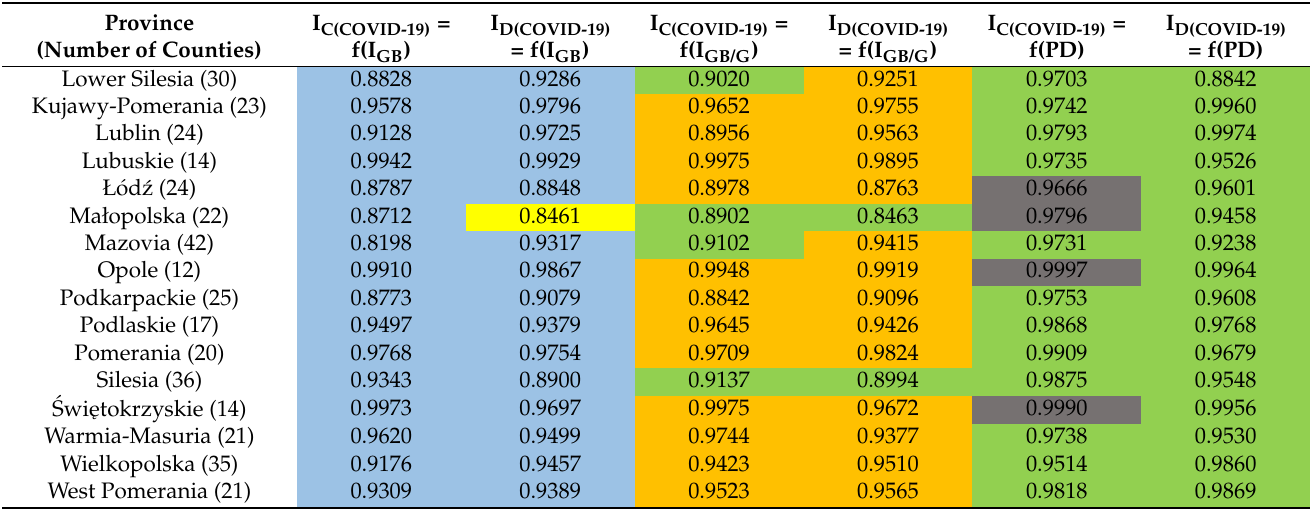
Table 2. Determination coefficients (R 2 ) of the relationships between the environmental characteristics (green-blue spaces index—I GB , population density—PD, and green-blue/grey index—I GB/G ) and the indices of: the total number of COVID-19 cases (I C(COVID-19 ) and the total number of COVID-19 deaths (I D(COVID-19 ) by